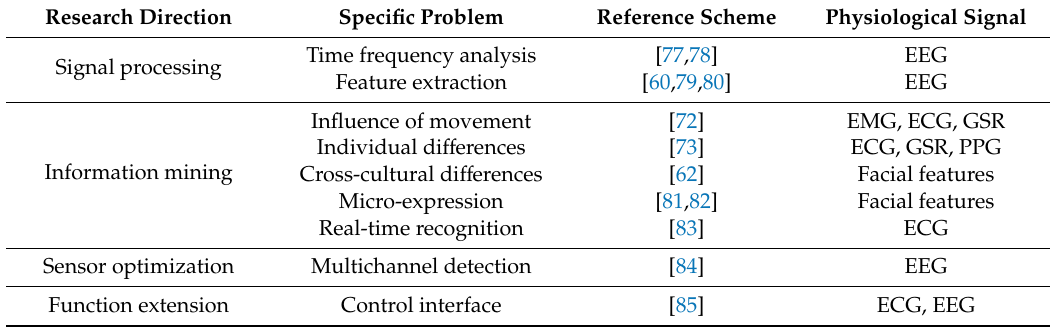
Table 3. Research directions for and the specific problems of Emotion Recognition Systems